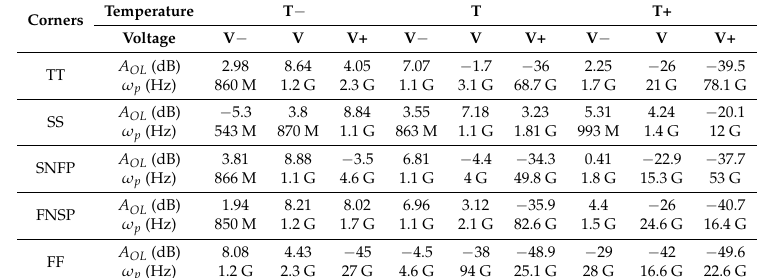
Table 1. Open-loop gain and dominant pole values over PVT variations with R L = 450 Ω .